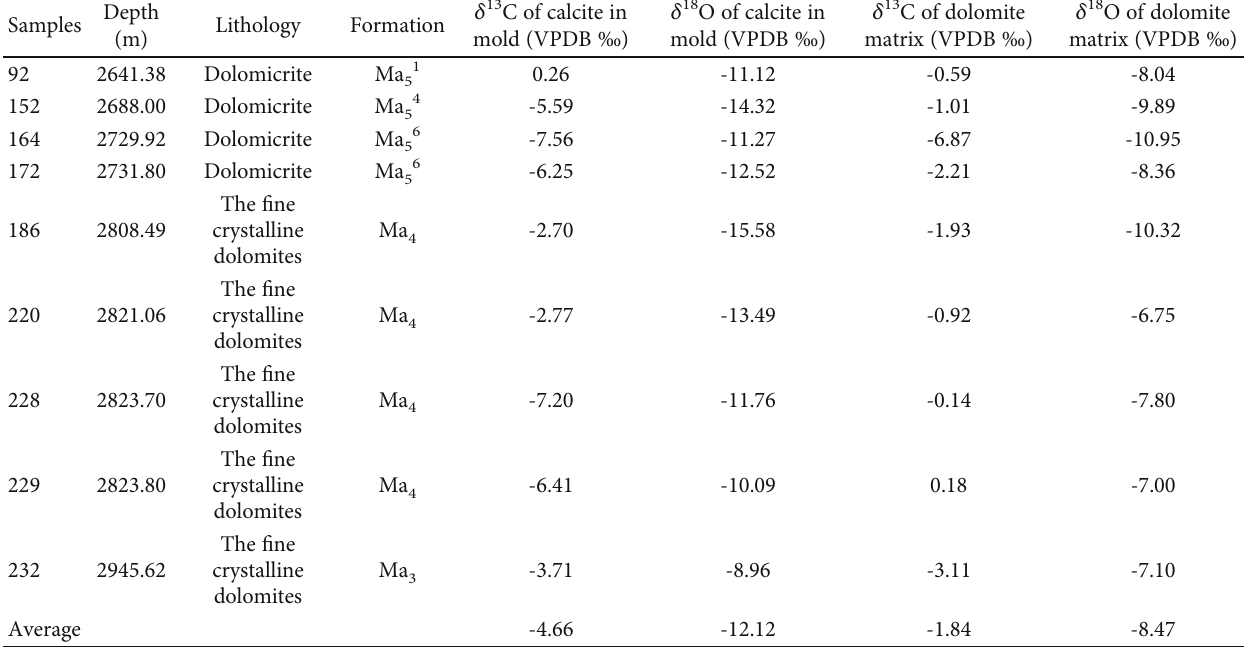
Table 3: Carbon and oxygen isotope results of calcite fi lling in mold and corresponding dolomite matrix in Yican 1 well in the southeastern Ordos